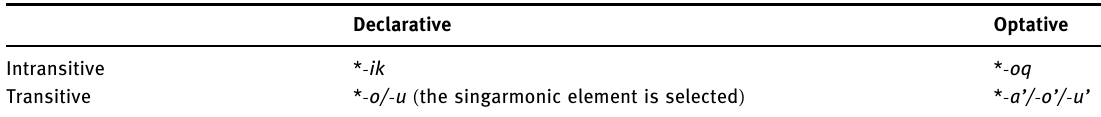
Table 2: Reconstruction of status su ffi xes for Proto -